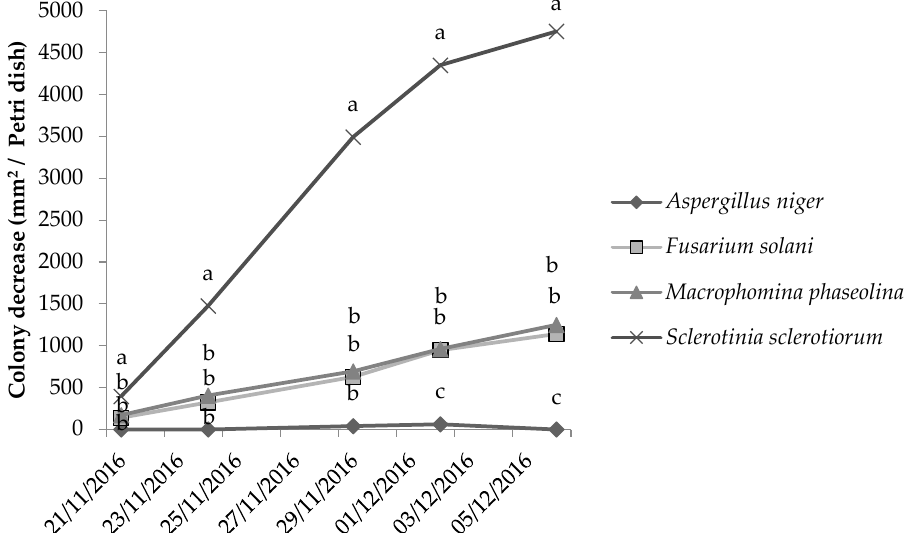
Figure 8. Average loss of mycelium in a feeding experiment where Porcellionides pruinosus individuals were offered four different fungi in Petri dishes. Different letters for the same sampling date indicate significant differences (ANOVA, Tukey’s post hoc test).